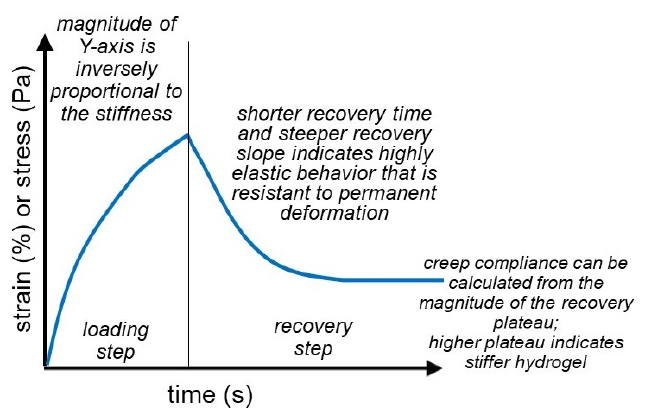
Figure 8. Creep recovery tests show the amount of applied strain a hydrogel can withstand and how the structure of the hydrogel recovers upon removal of this applied strain.